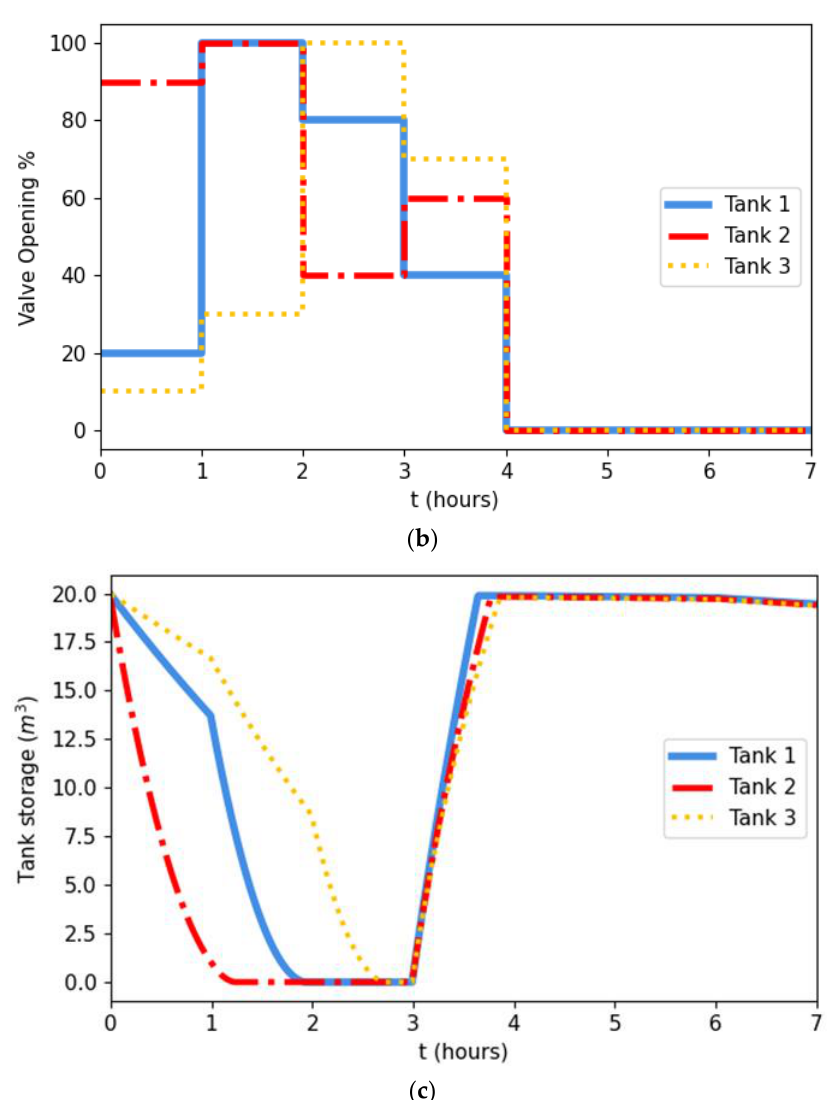
Figure 3. Results of applying the optimization process on a 1-h constant rain event of 5% probability. ( a ) Flow pattern of benchmark run (no controlled releases—red) and from applying the optimized controlled release policy (blue). Q objective , which was used to evaluate the policy’s fitness according to Equation (5), is plotted in dashed green. ( b ) The control release policy that was derived by applying the genetic algorithm—the degree of each valve’s opening during the simulated event. ( c ) Water stored in each tank during the simulated event.